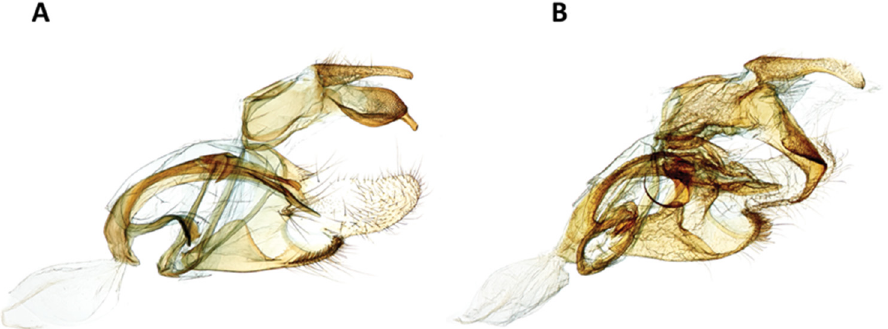
Figure 10. Medial view male genitalia ( A ) Casmara subagronoma (USNMENT01328210, USNM slide # 146,475); ( B ) C. agronoma (USNMENT01200872, USNM slide # 146,475); ( B ) C. agronoma (USNMENT01200872, USNM slide # 146,474).